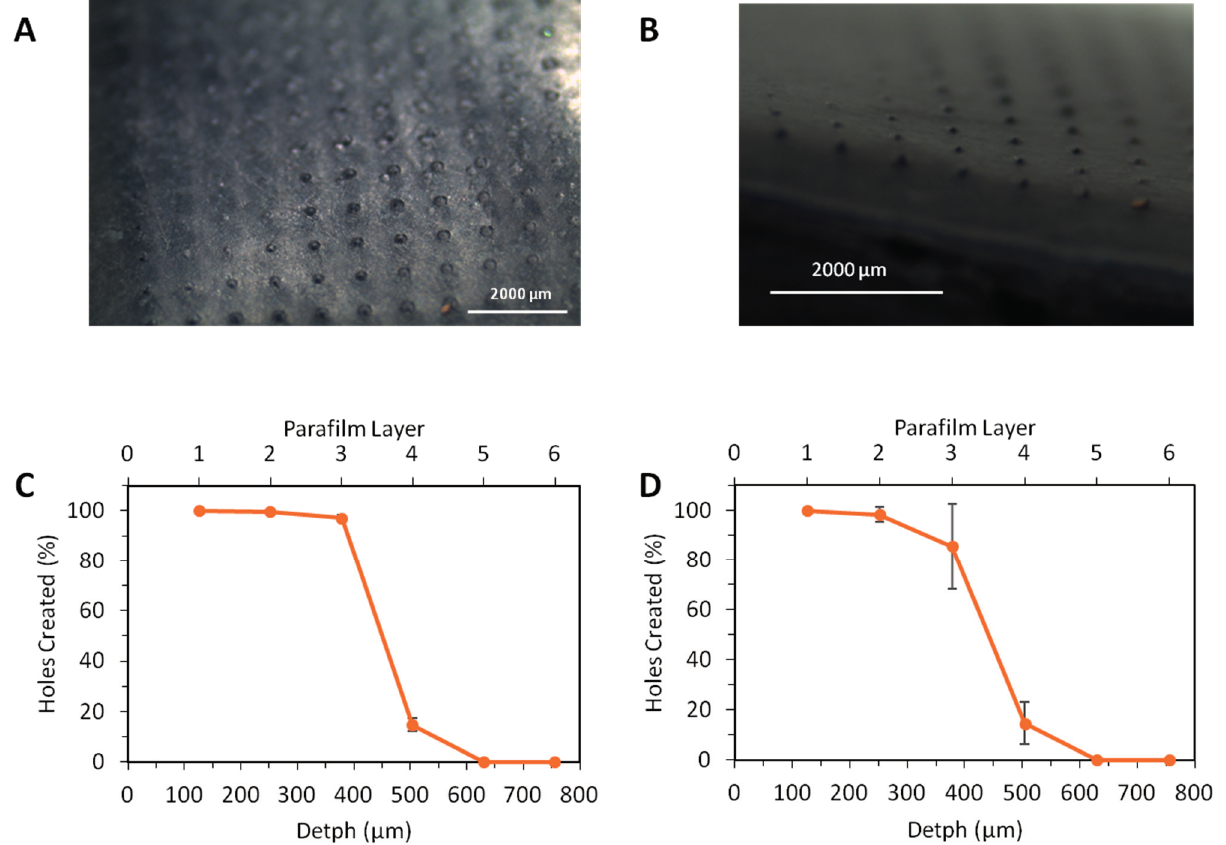
Figure 3. Image of ( A ) the Parafilm™ after microneedle insertion viewed using polarising lenses and ( B ) the microneedles piercing one layer of Parafilm™. Parafilm™ insertion test for ( C ) 0.5% and ( D ) 5% methylene blue loaded microneedles following a manual force application (Means ± S.D., n =